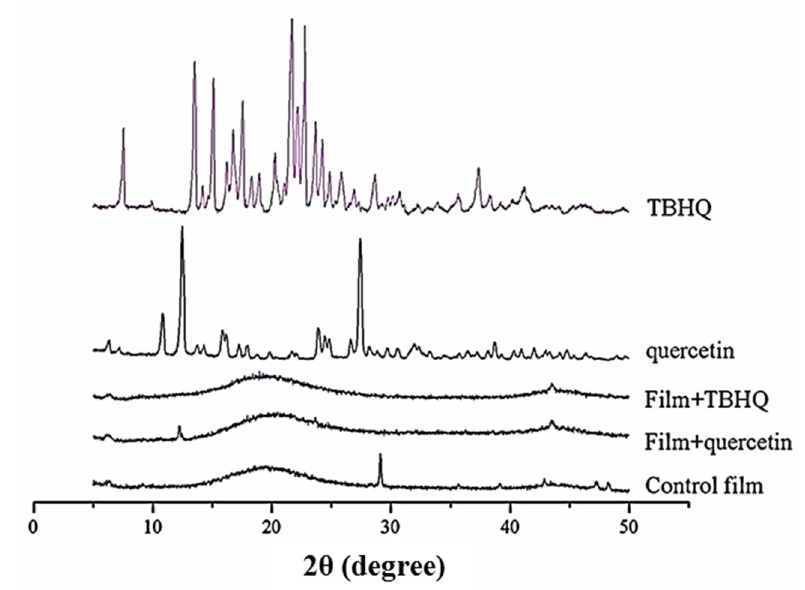
Figure 3. XRD di ff ractograms of quercetin, TBHQ, control cassava starch–CMC film, and cassava Figure 3. XRD diffractograms of quercetin, TBHQ, control cassava starch–CMC film, and cassava starch–CMC films with quercetin and starch–CMC films with quercetin and TBHQ.